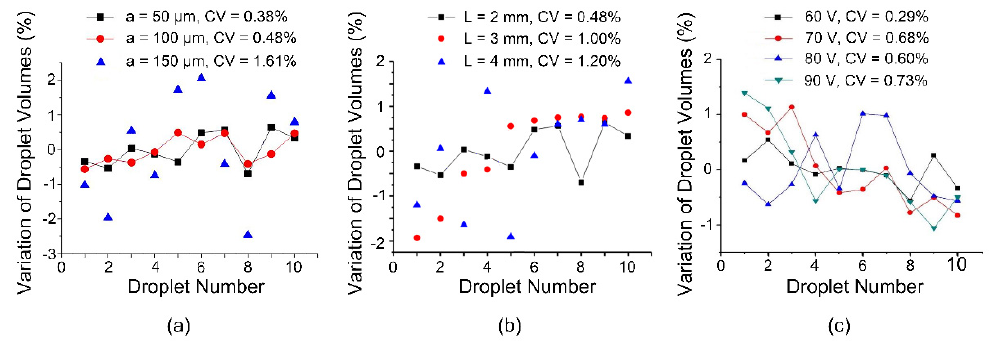
Figure 5. Volume variation of droplets as a function of ( a ) the neck width of the dumbbell-shaped sub-electrode, ( b ) the length of the dumbbell-shaped sub-electrode (the width remains 2 mm), and ( c ) the actuation voltage. Each dot is averaged over 5 measurements, and error bars are not shown for visual clarity.